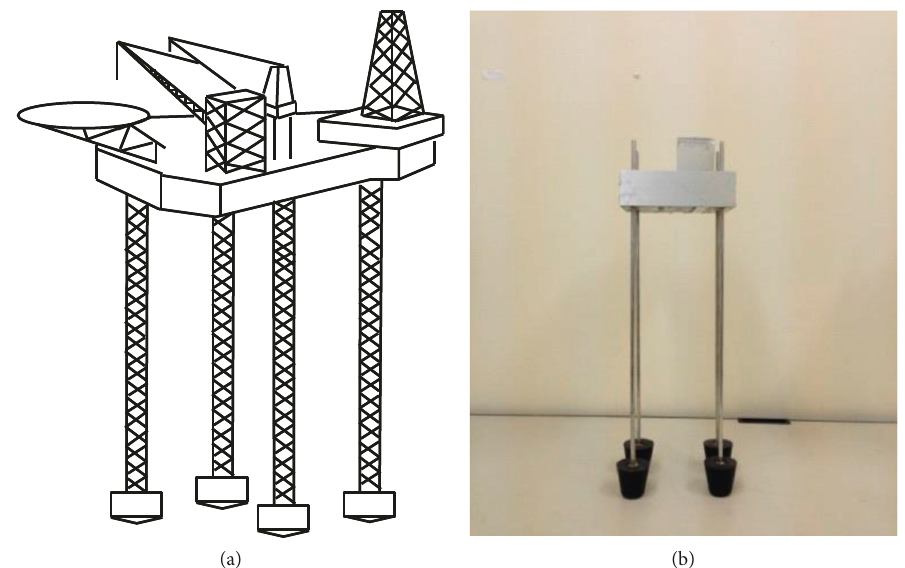
Figure 1: Jackup offshore platform (a) and 1 :200-scale model (b).